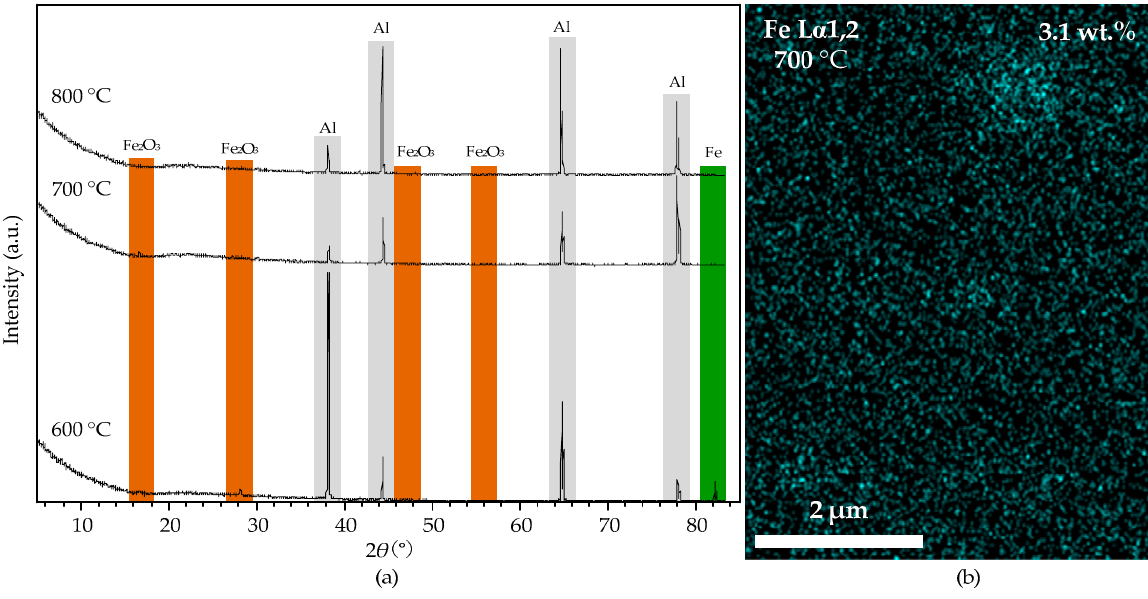
Figure 12. ( a ): the XRD spectra of the aluminum foil without alumina film after reduction process at 600, 700, and 800 °C. ( b ): the EDS mapping micrograph of the substrate after reduction process at 700 °C.